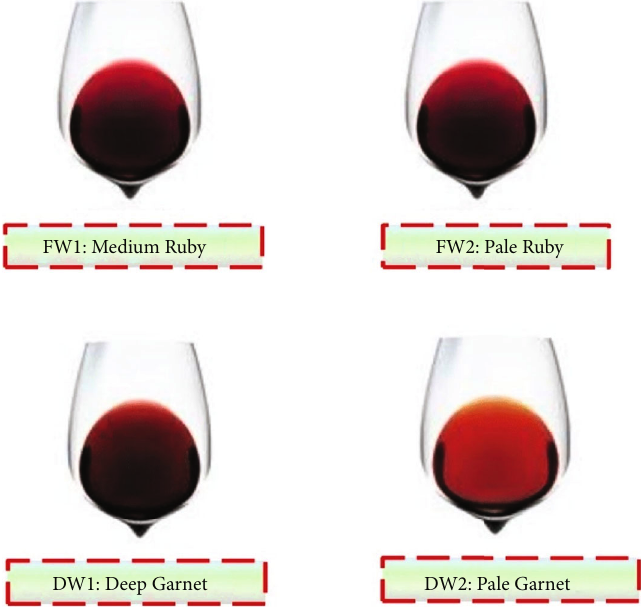
Figure 4: Colour di ff erence between foreign and domestic wines (adapted from